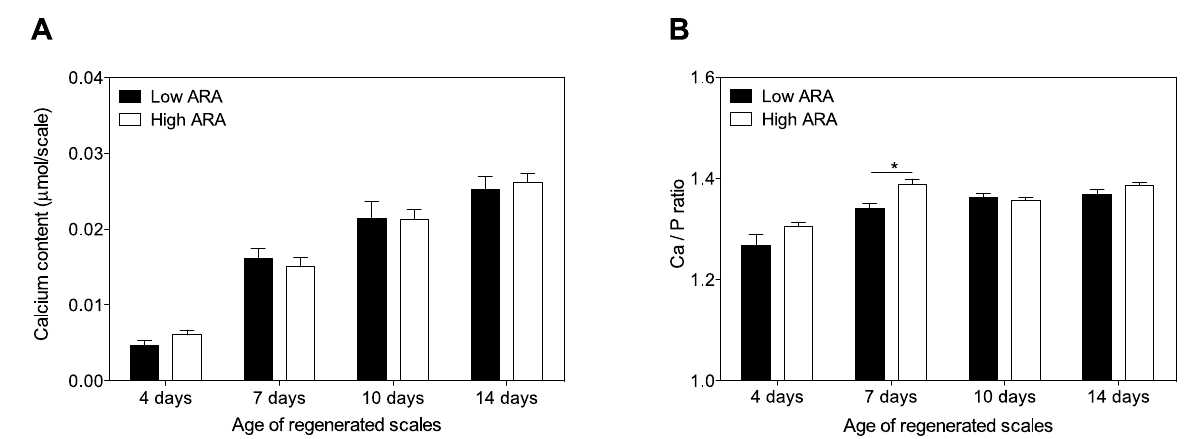
Figure 4. Analysis of scale mineralization during regeneration. A : Absolute calcium contents in regenerating scales sampled at different time points after scale removal. Calcium content increases similarly in both groups as the scale grows during regeneration. B : Calcium:phosphorus molar ratio of regenerating scales of different ages. The ratio increases in both groups from day 4 to 7, indicative of a changed mineral composition on the scale matrix. Effect of the diet is only observed on day 7; the Ca:P ratio in the high ARA groups is significantly increased compared to the low ARA group. Samples are expressed as mean 6 SEM (N=9); black bars represent samples obtained from fish fed the low ARA diet, and white bars represent samples from fish fed the high ARA diet. Statistical testing was conducted with the Students T-test (* p , 0.05).